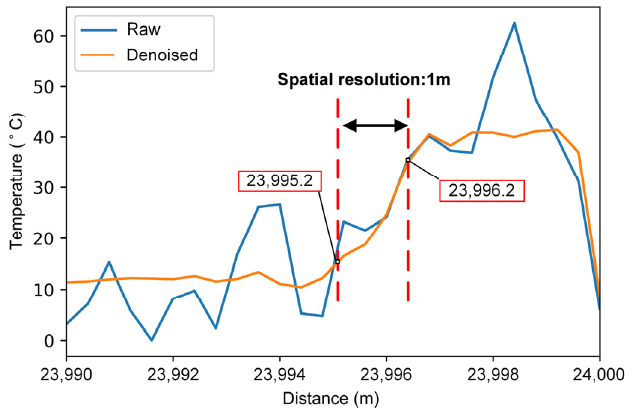
Figure 10. Temperature result when the end of 24 km LWPF